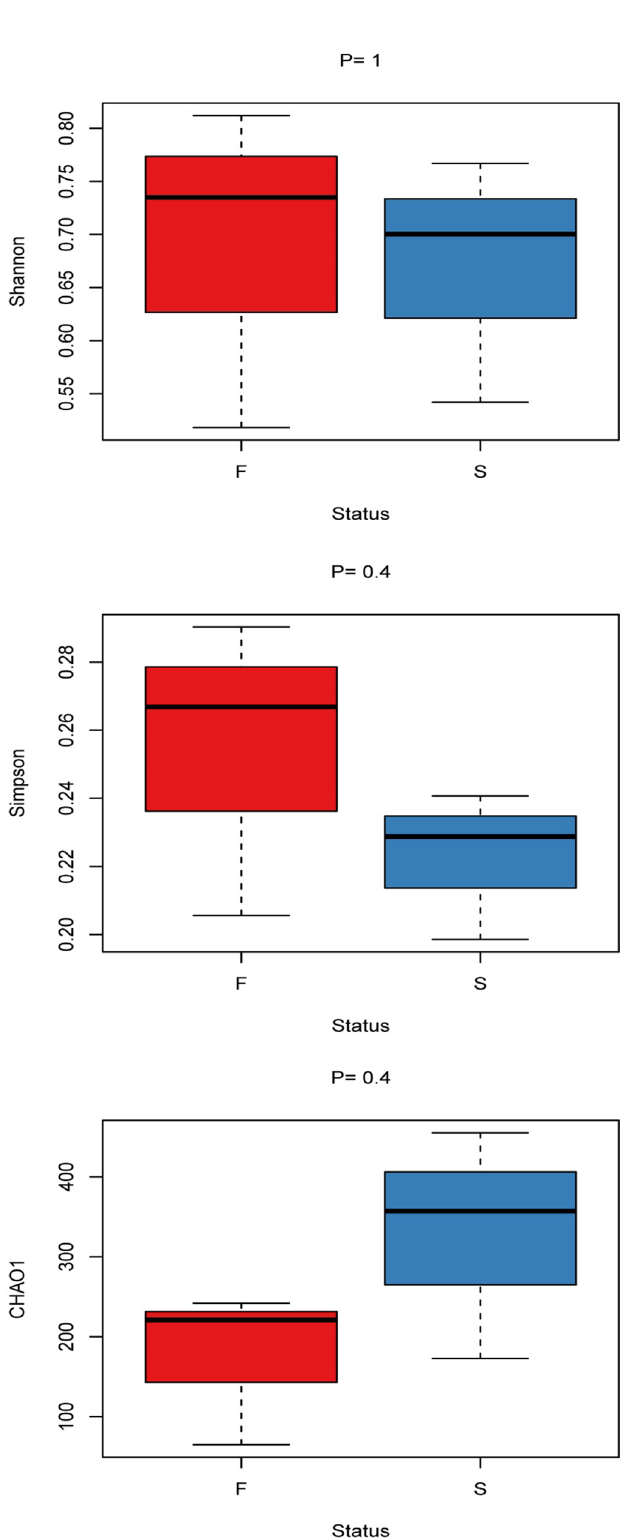
Figure 1. Alpha-diversity boxplot of blood-fed (F, red) and starved (S, blue) bed